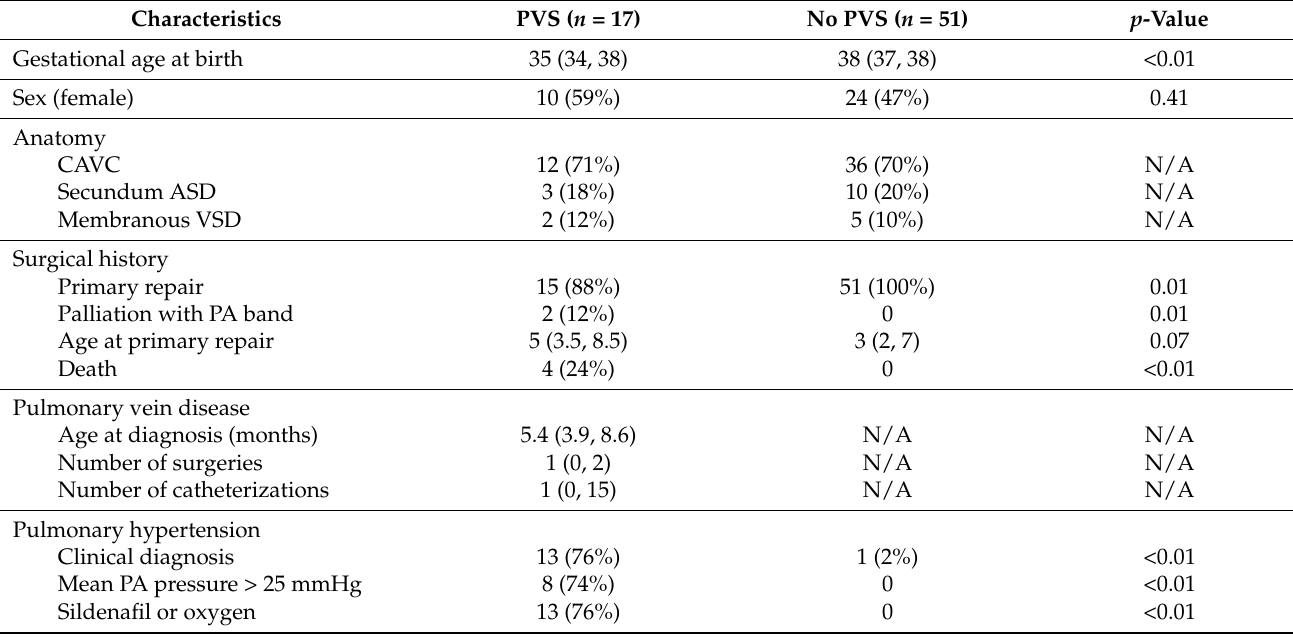
Table 3. Characteristics of Patients with Multivessel Pulmonary Vein